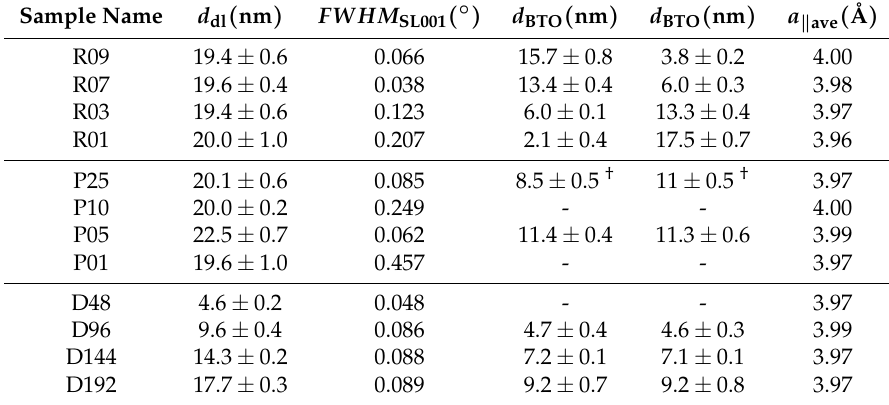
Table 2. Results of XRD measurements. d dl values are derived from superstructure fringes in 2 θ - ω scans, d BTO and d BTO are derived from fits of XRR measurements, and a (cid:107) ave values are derived from (103) RSMs. The error margin of a (cid:107) ave is estimated to be ∼